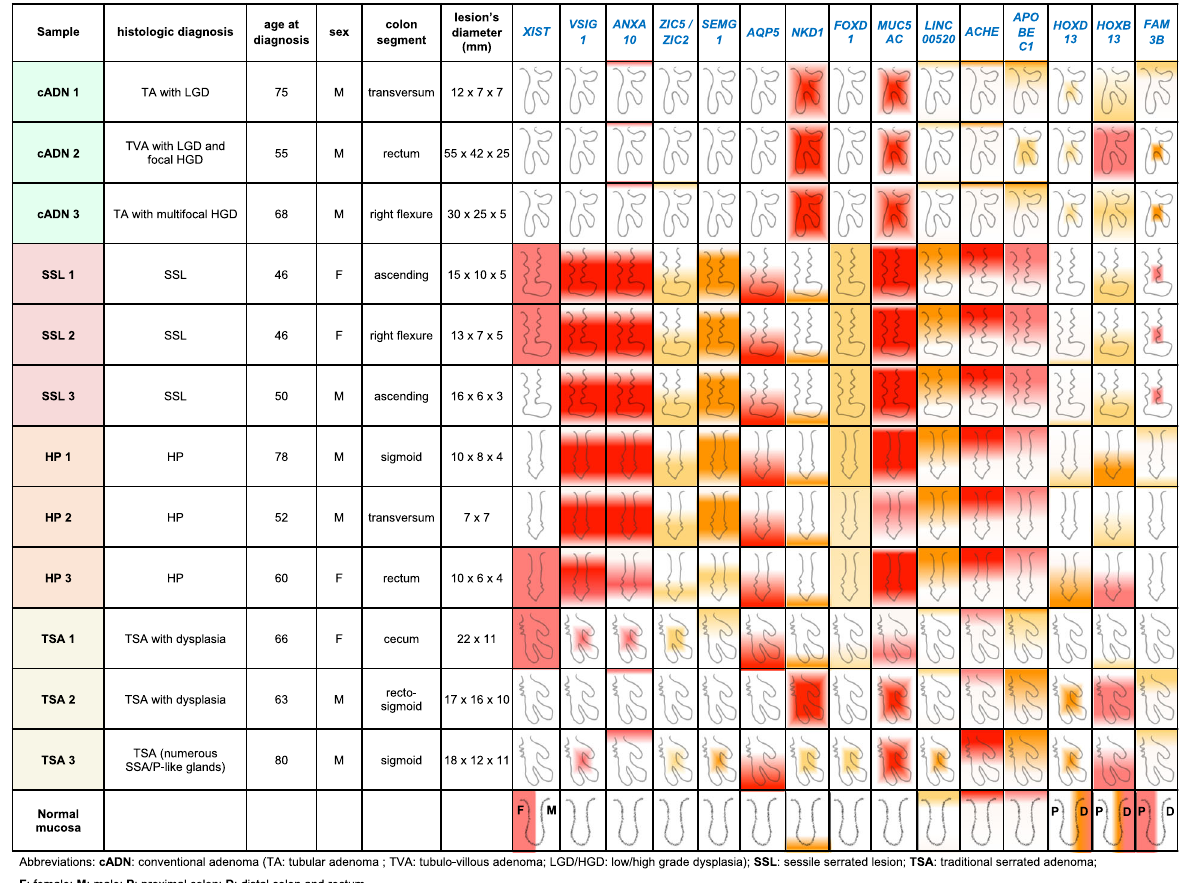
Table 1 Clinical and in situ hybridization data of the analyzed